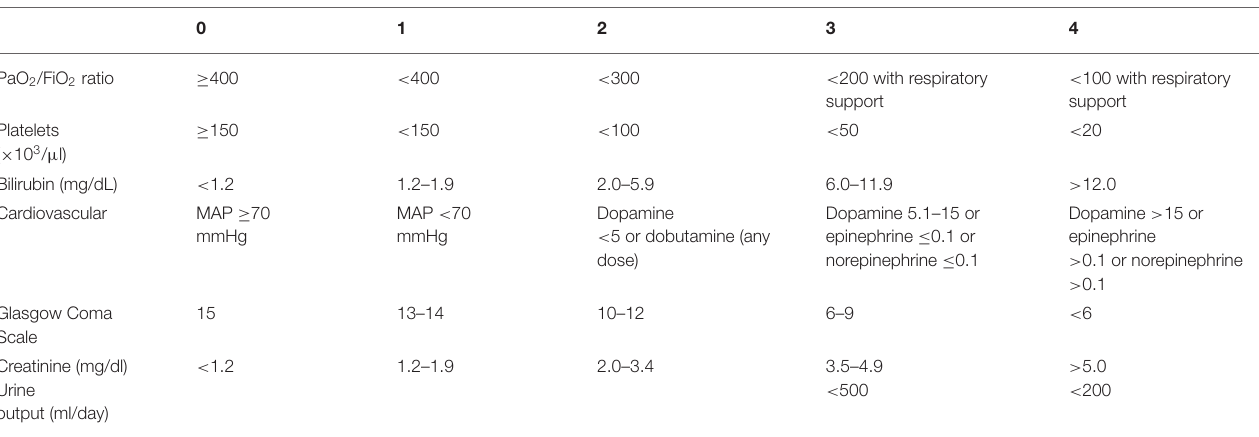
TABLE 2 | The sequential organ failure assessment (SOFA) score in